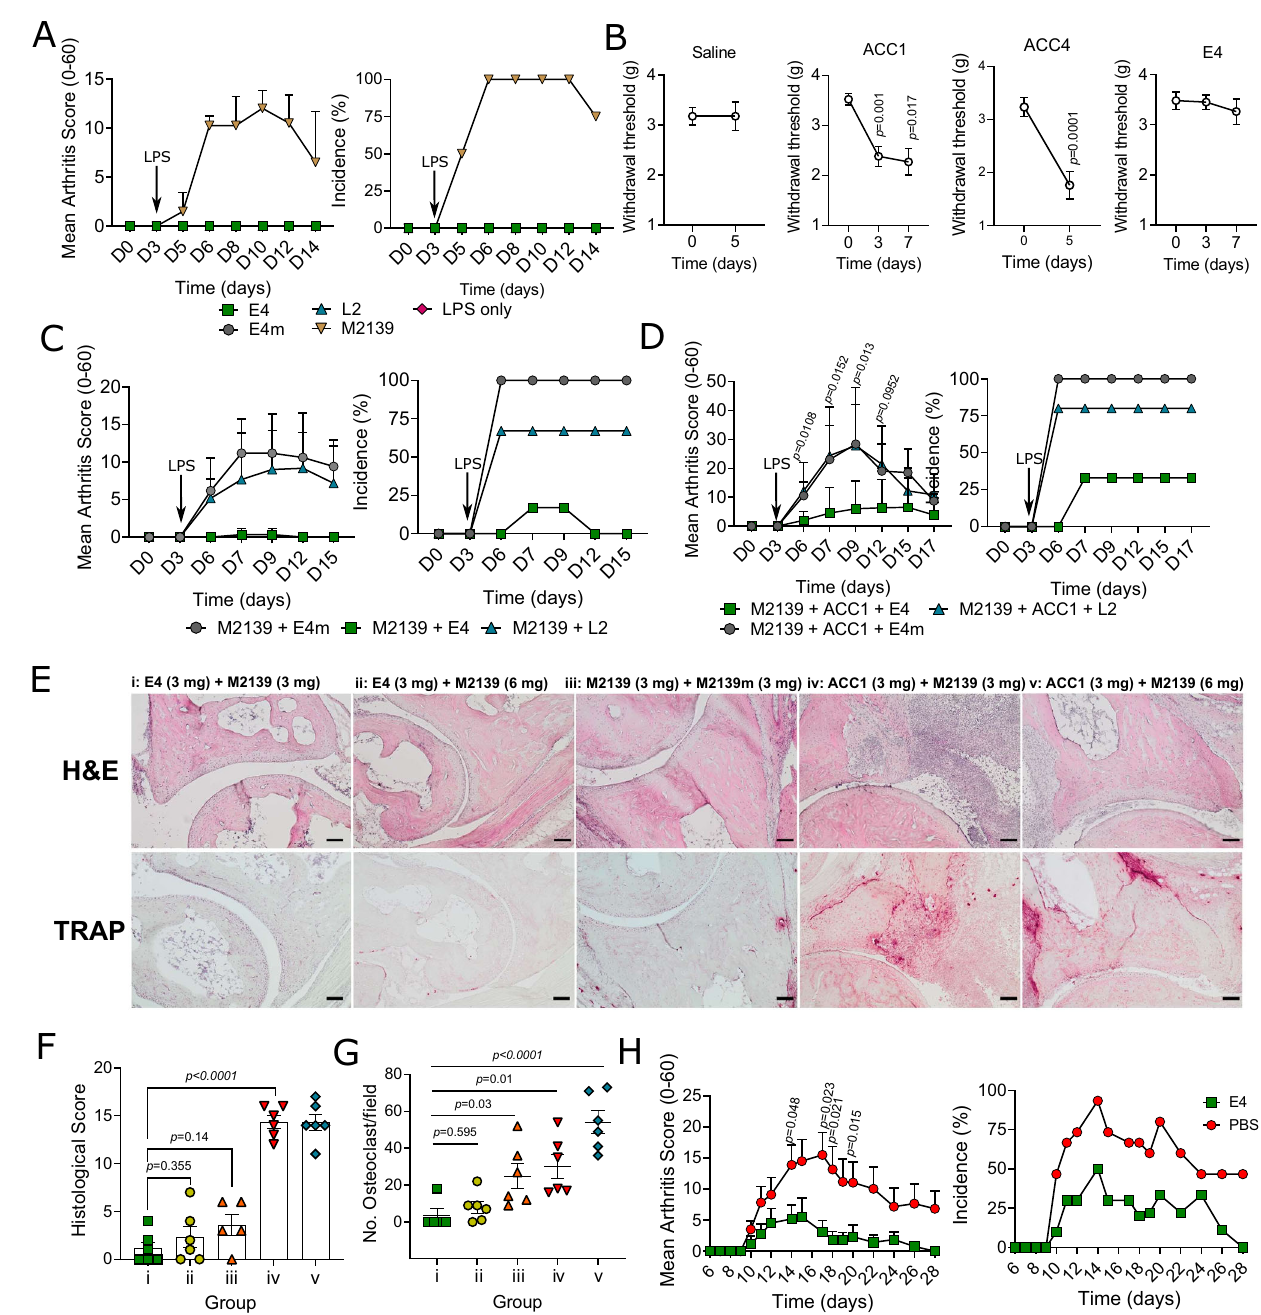
Fig. 2 | Effects of mAbs in arthritis mouse models. A Common ACPAs do not inducearthritis. A dose of4mg per mouse for eachantibody wasintraperitoneally injected on day 0 ( n =3 for LPS and 4 for others), followed by a boost with LPS on day 3. Arthritis scores are analyzed using Mann – Whitney test (two-tailed) and presented as mean±SD. B E4 does not induce pain-like behavior. 2mg of E4 and ACC1, and 4mg of ACC4 or saline were injected on day 0 ( n =6 for ACC1, E4 and saline, and 12 for ACC4), mechanical allodynia was assessed by paw withdrawal response. Data were assessed using paired t test (two-tailed) and presented as mean±SEM. C , D E4 protects Cia9i mice against collagen-antibody-induced arthritis (CAIA). Arthritogenic COL2 antibody M2139 (3mg) wasinjected either ( C ) alone ( n =5 for M2139+E4m and 6 for others) or ( D ) in combination with another COL2 antibody ACC1 (3mg) ( n =6) through i.v or i.p on day 0, followed by a boost withLPSonday3.E4/E4m/L2(3mg)wereinjectedwithorwithoutCOL2antibodies